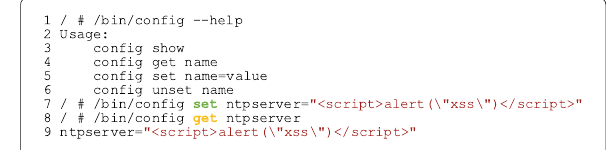
Fig. 5 Code Snippet of D-CONF